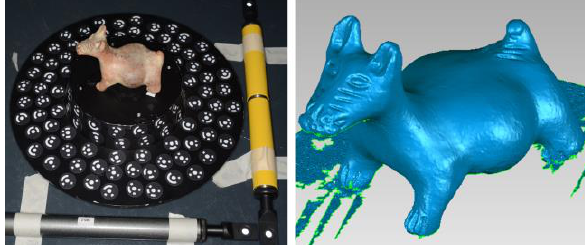
Figure 8. Reference point field (left) and result of fringe projection measurements (right)